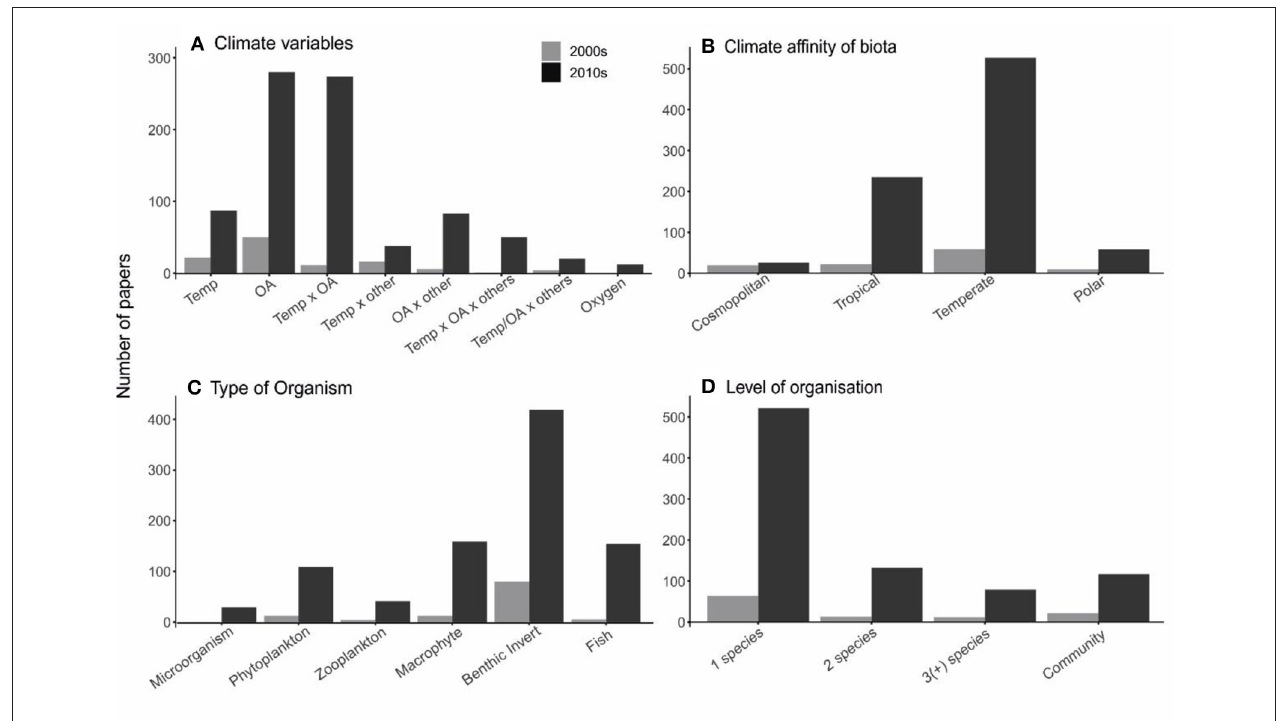
FIGURE 2 | Characteristics of Marine Climate Change Experiments (MCCEs) published in two decades (2000–2009 vs. 2010–2019), shown as actual number of papers in each decade. Studies were classified by (A) the climate variables that was experimentally manipulated, (B) the climatic region of which the study organism(s) belonged, (C) the type of organism (experiments with multiple types were recorded more than once) and (D) the number of species studied. In panel (A) “Temp” = temperature, “OA” = ocean acidification, “Oxygen” = deoxygenation experiments. In panel (D) numerals donate number of species/taxa studied, “comm” = community level experiment (as reported by